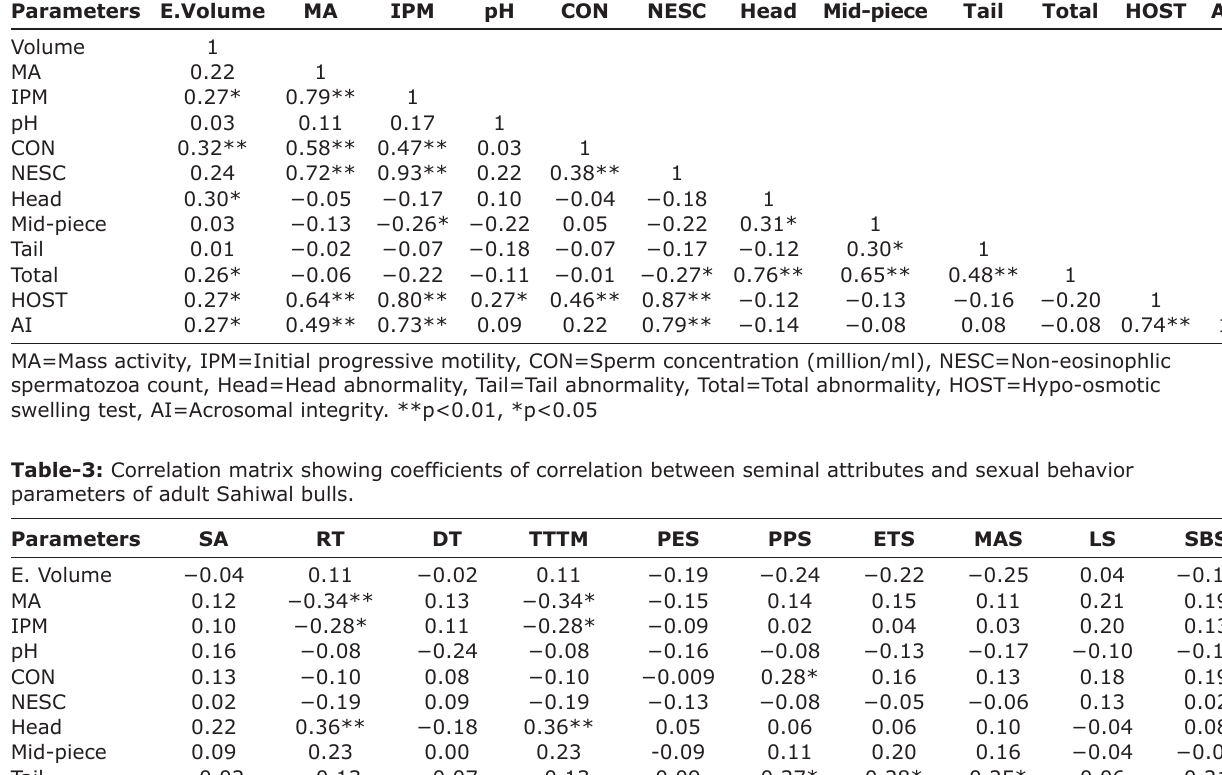
Table-2: Correlation matrix showing coefficients of correlation among seminal attributes of adult Sahiwal bulls. Parameters E.Volume